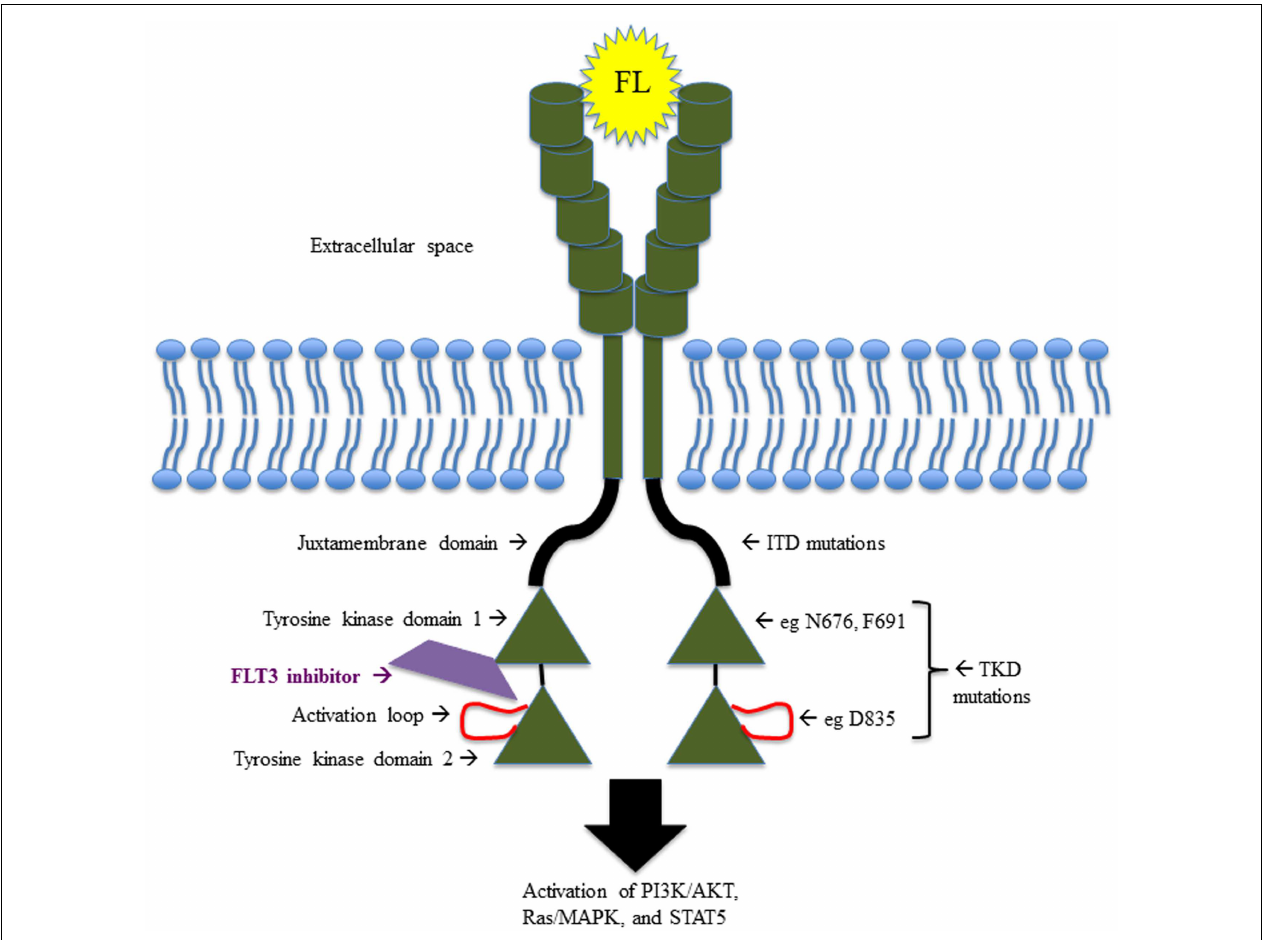
FIGURE 1 | Schematic illustrating the structure and function of FLT3, including the sites of the most common activating mutations .